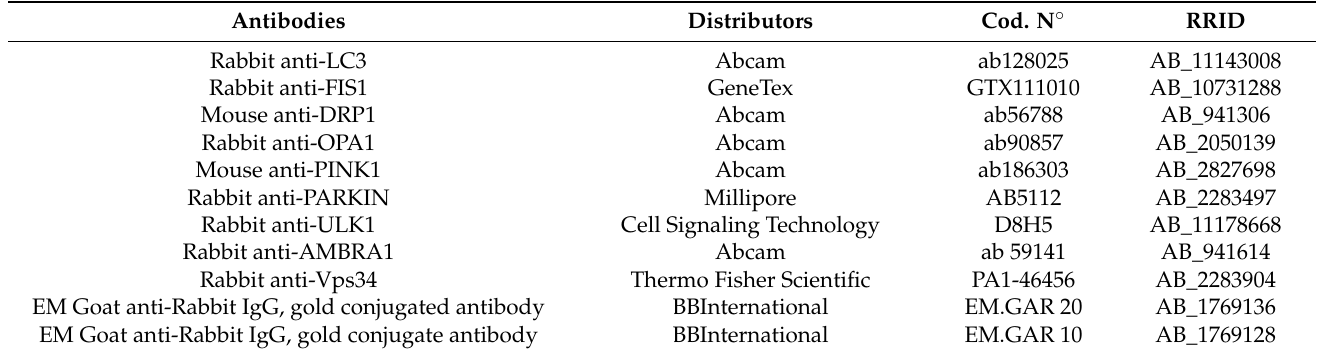
Table 2. Sources and identification of each antibody used in the